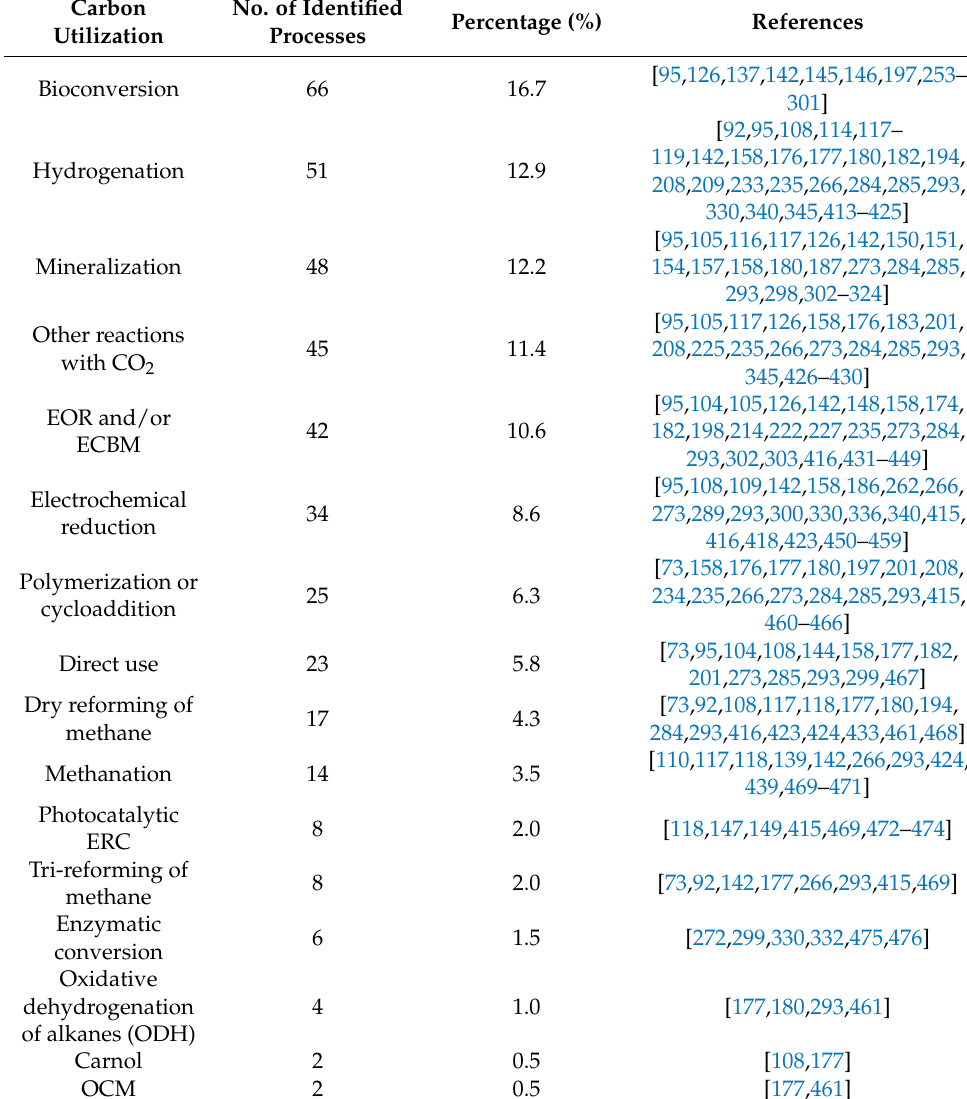
Table 18. Carbon dioxide utilization processes cited most